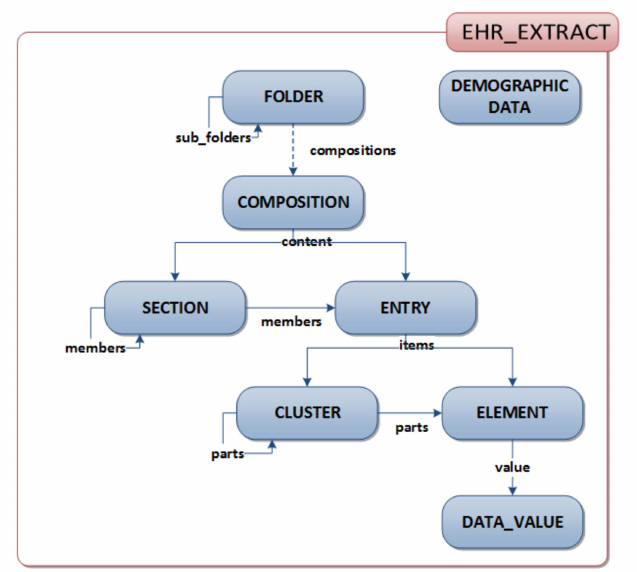
Figure 1. Main classes of clinical information in the International Organization for Standardization standard, ISO 13606 (source: